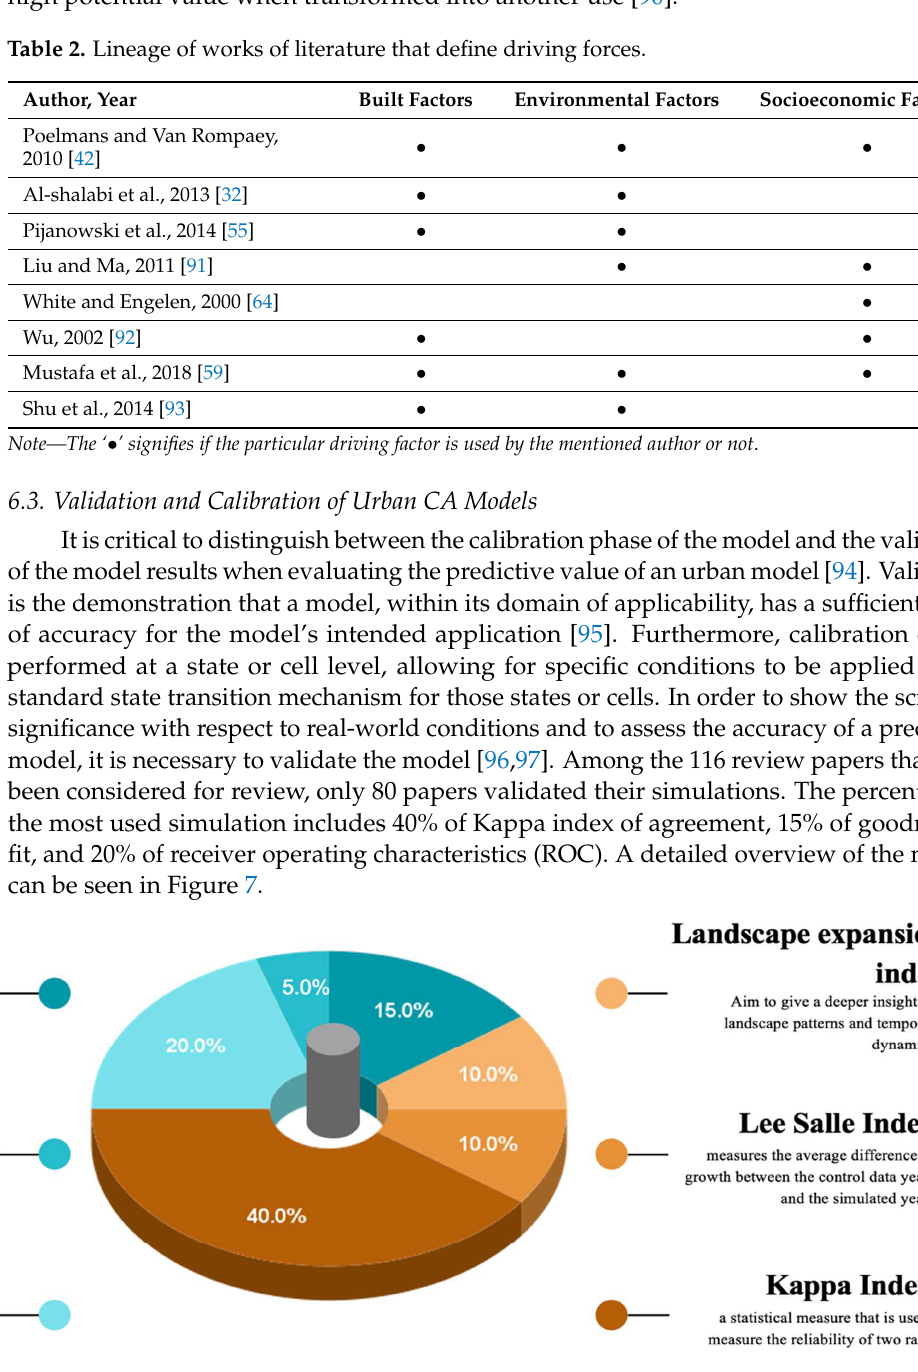
Figure 7. An overview of validation method adopted across considered articles.